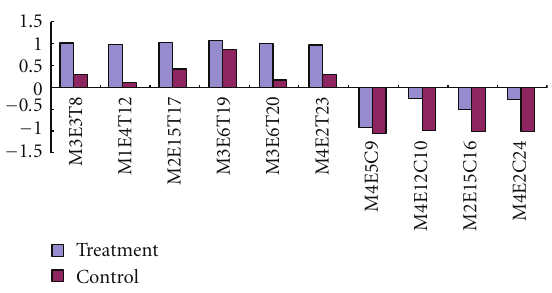
Figure 2: Validation of 10 di ff erentially expressed genes screened in cDNA-SRAP by Real-time